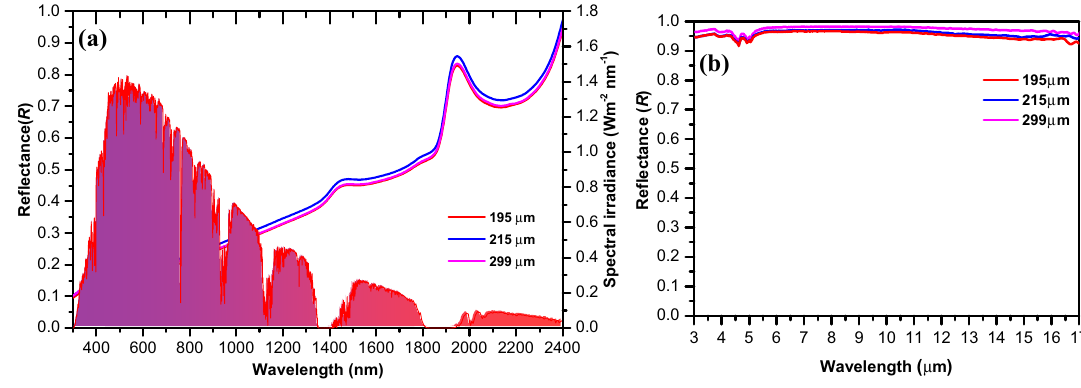
Fig. 7 The measured spectral reflectance ( R ) of the Ni–Al coatings with the three thicknesses in the wavelength of a UV–Vis-NIR regions, together with spectral irradiance at AM 1.8 and b the IR